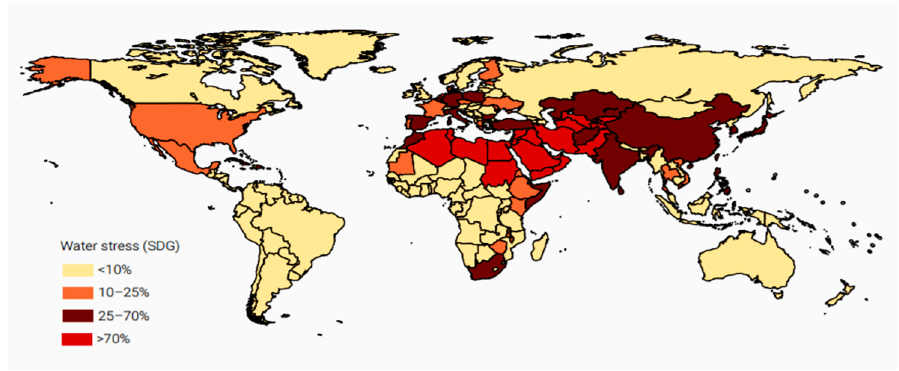
Figure 1. Levels of water stress by country (2000–2015) [7]. (© 2018 International Water Management Institute (IWMI) and the Food and Agriculture Organization of the United Nations (FAO) Aquastat).